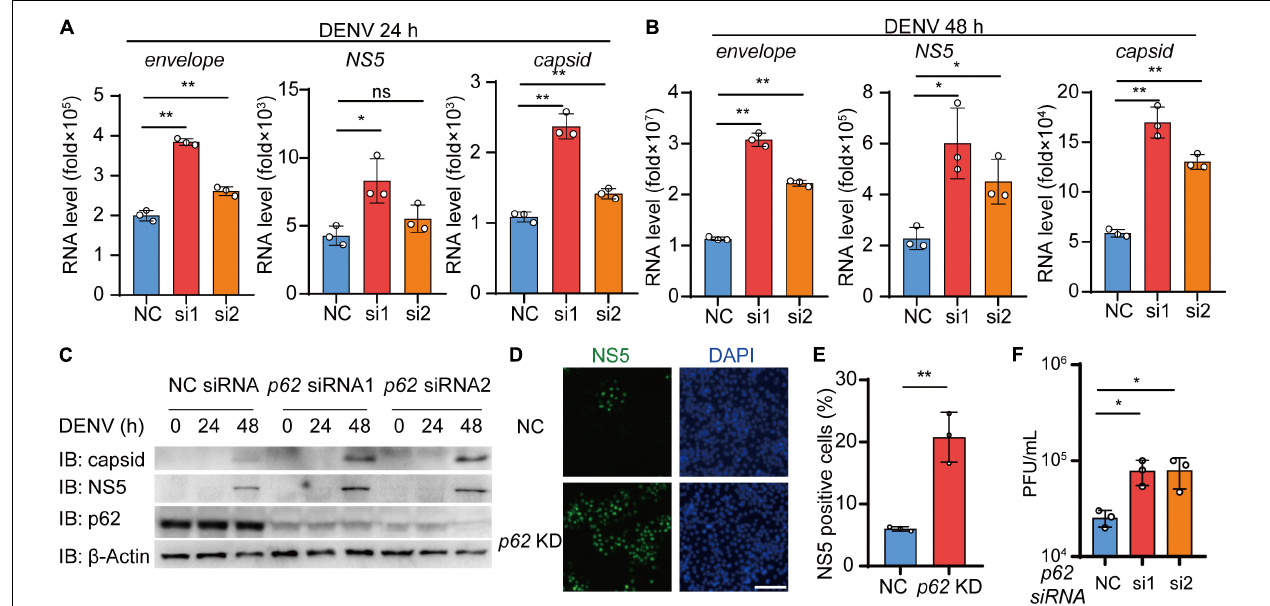
FIGURE 6 | p62 restricts the replication of dengue virus (DENV). (A,B) Huh7 cells transfected with control (NC) or p62 -specific siRNA were infected with DENV (MOI = 0.5) for 24 h (A) and 48 h (B) . Relative RNA levels of DENV E protein , C protein, and NS5 were measured by real-time PCR. (C) Huh7 cells were transfected with NC or p62 -specific siRNA, followed by infection with DENV (MOI = 0.5) at different time points, and the lysates were immunoblotted with indicated antibodies. (D) Confocal microscopy of WT or p62 KD Huh7 cells infected with DENV (MOI = 0.5) for 24 h, followed by labeling of NS5 with a specific primary antibody and an Alexa Fluor 488 conjugated anti-rabbit-IgG secondary antibody (green). Scale bar, 200 µ m. (E) The graphs display the relative percentage of positive cells in (D) . Data represent replicated measurements in at least 1,000 cells for one independent replicate. (F) Viral plaque analyzes of WT or p62 KD Huh7 cells infected with DENV (MOI = 0.5) for 48 h. Data in (A,B,E,F) are expressed as mean ± SEM of three independent experiments. * p < 0.05, ** p < 0.01, ns, not significant (two-tailed Student’s t -test). All the experiments are representatives of three independent biological experiments with similar